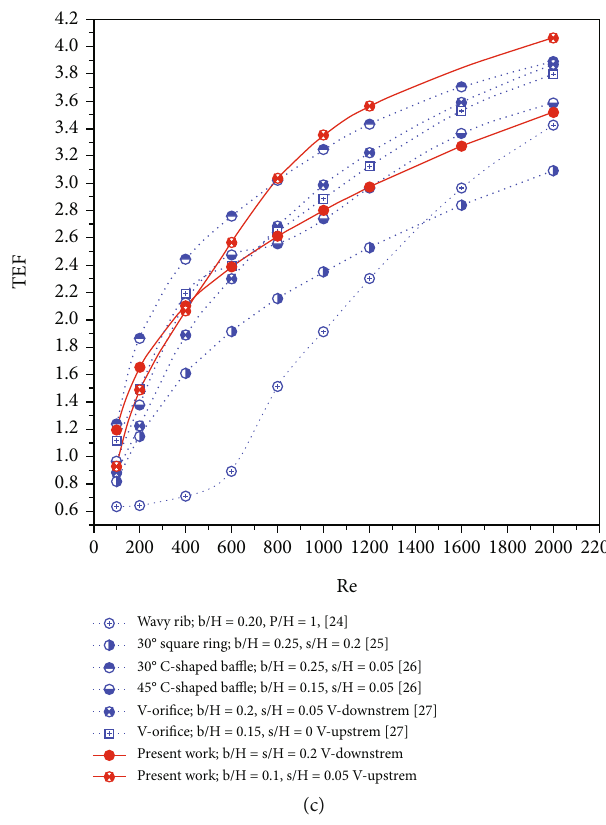
Figure 16: Comparison with the previous works for (a) Nu/Nu